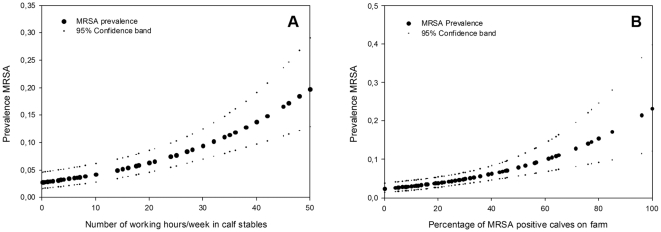
Human MRSA prevalence, working hours in calf stables per week and MRSA positive calves on the farm.Figure 1 A shows the relationship between MRSA carrier prevalence in humans and the number of working hours / week in the calf stable, adjusted for gender, age, smoking habits and percentage of positive calves on the farm. Figure 1 B shows the relationship between MRSA carrier prevalence in humans and the percentage of positive calves on the farm, adjusted for gender, age, smoking habits and number of hours working/week in calf stables. In both figures smoothed plots are given with 95% confidence bands.